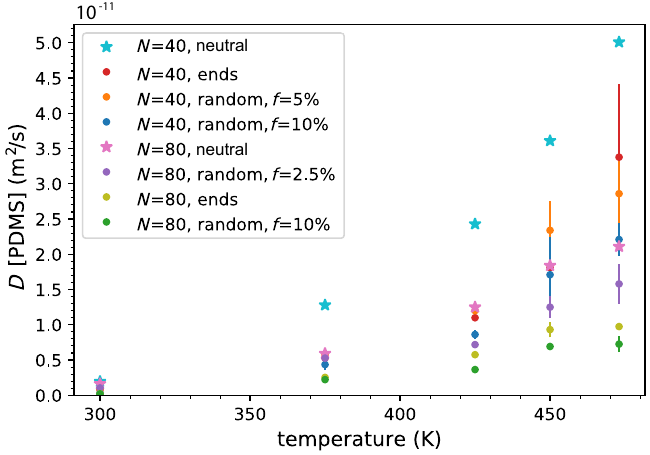
Figure 7. PDMS chain diffusion coefficient versus temperature for end- and randomly grafted functionalized ionic PDMS and neutral PDMS